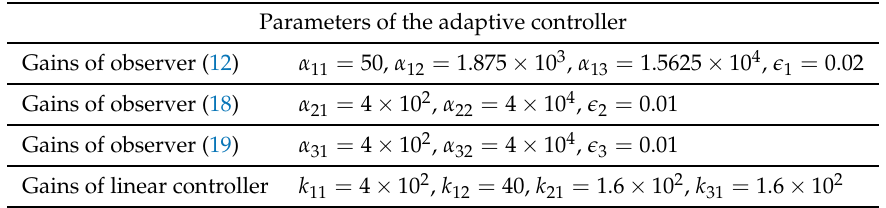
Table 1. Parameters of adaptive pitch